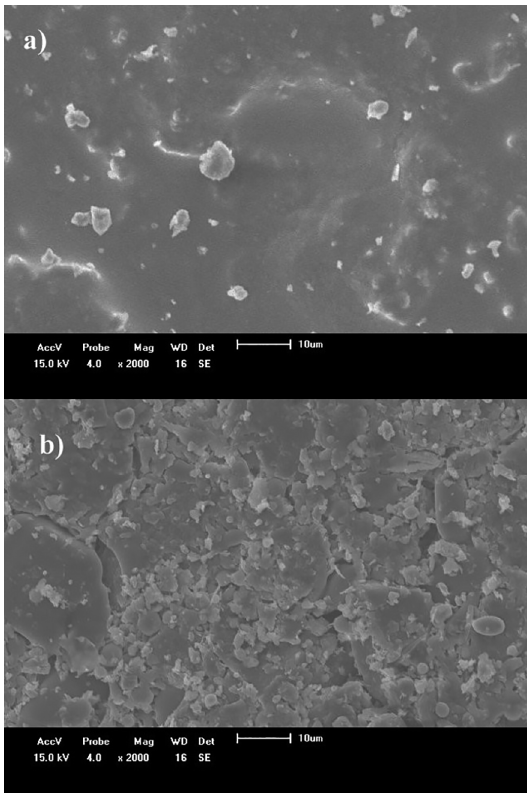
Figure 3. SEM micrographs of the aluminous porcelain pieces fired at 1300 ºC: (a) TF10 formulation; and (b) TF30 formulation. The linear shrinkage of the fired porcelain pieces is shown in Figure 4. As may be observed, the porcelain pieces presented linear shrinkage values ranging from